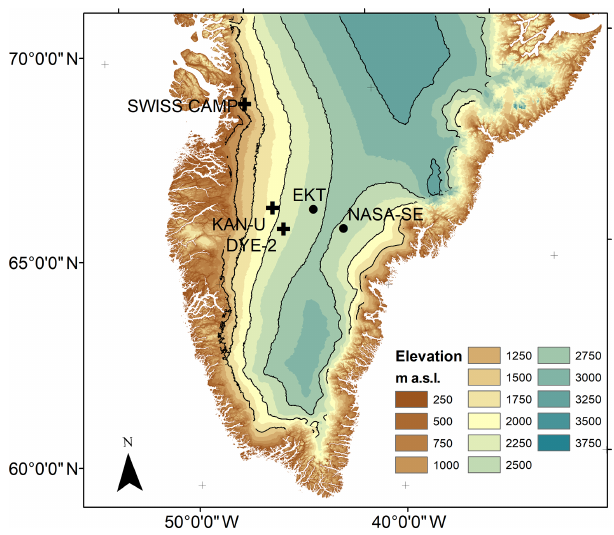
Figure 1. Map displaying locations of radar transects investigated for this study in southern Greenland (black crosses). The black dots indicate additional locations, where snow pits were dug for snow density analysis. The colors are 250m elevation bands with the maximum elevation per band indicated; the black contour lines are at 500m intervals. The underlying digital elevation model was gen- erated by Howat et al.